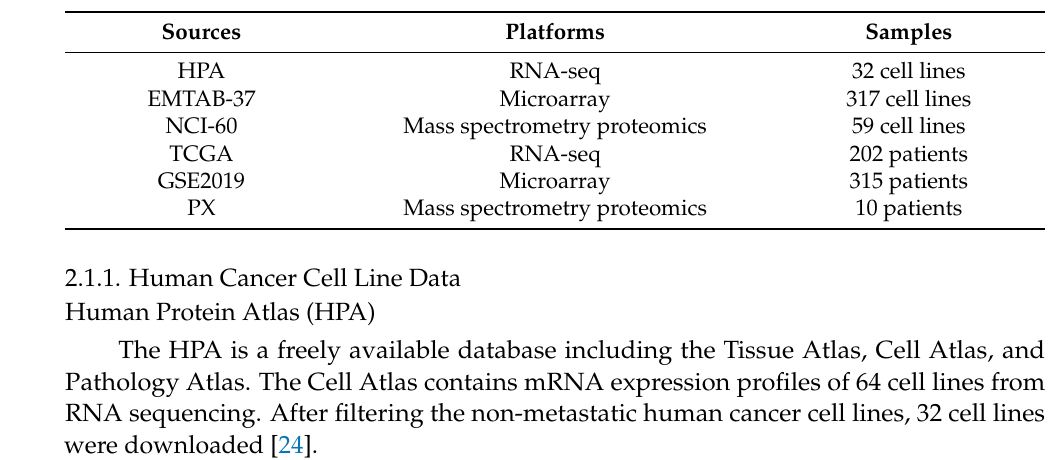
Table 2. The sources, platforms, and the number of samples we used in this